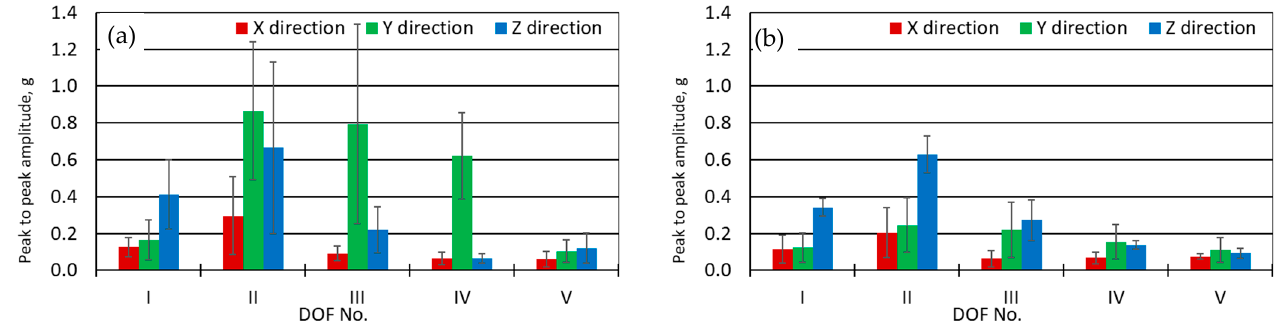
Figure 12. Peak-to-peak vibrations amplitudes evaluated after rotation of separate joints in ( a ) clockwise direction; ( b ) anti-clockwise direction. Statistical evaluation processed according to Equations (8)–(13). Robot start position marked in Figure 3a.